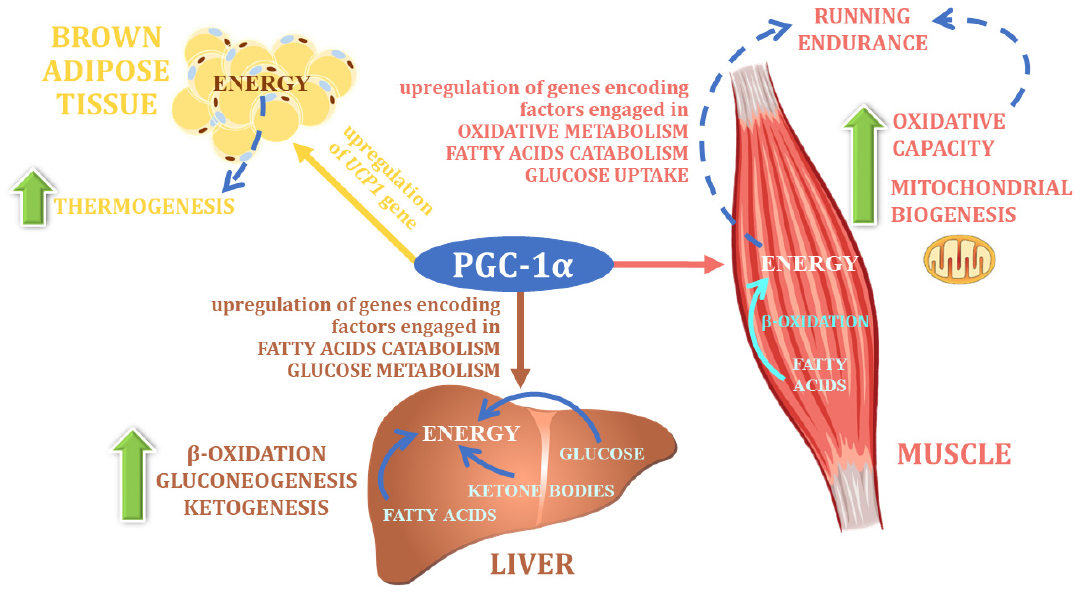
Figure 5. The main physiological function of PGC-1 α (own elaboration, after: Cheng et a. 2018 [16]). UCP1—uncoupling protein 1.